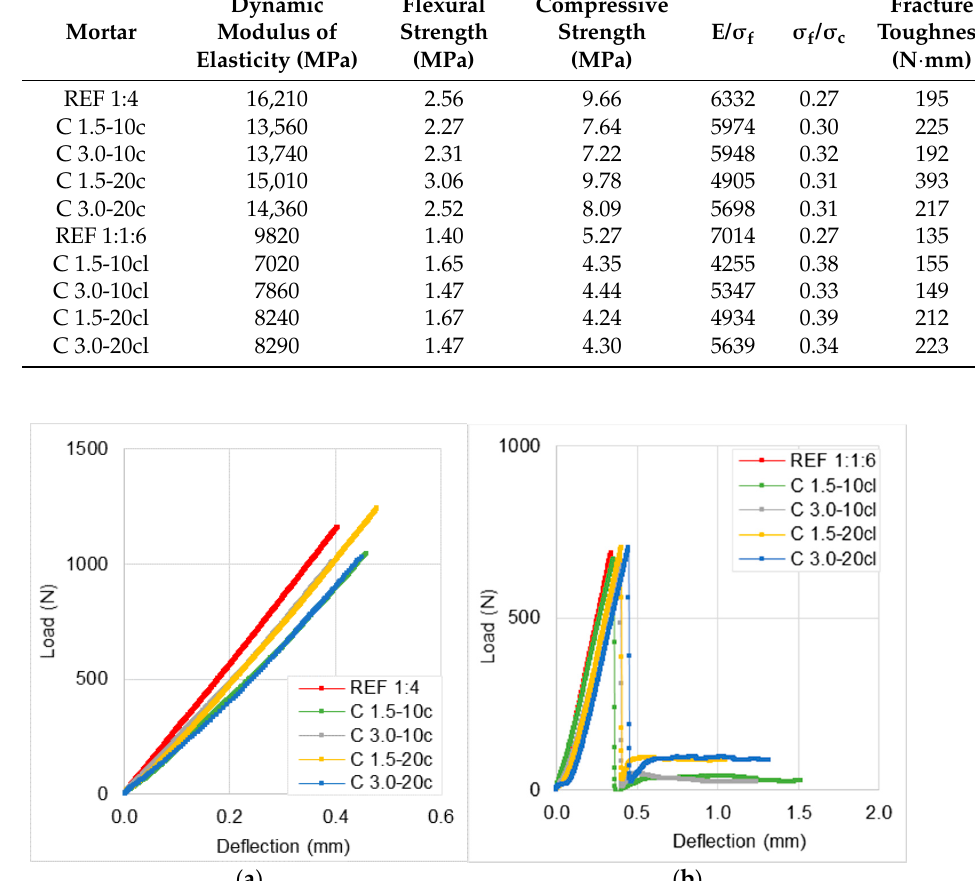
Figure 11. Load/deflection curves obtained from flexural strength of the mortars: ( a ) cement mortars and ( b ) cement ‐ lime mortars.